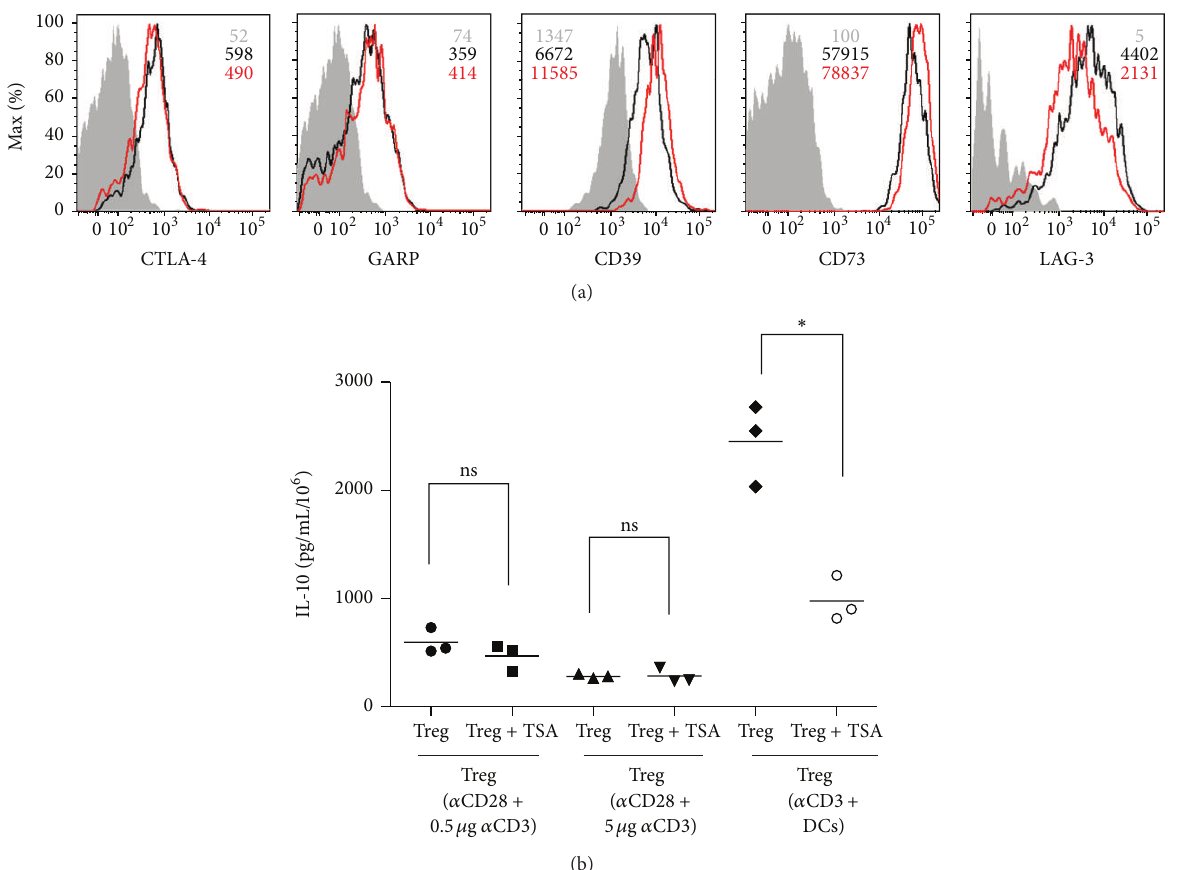
Figure 4: Phenotypical characterization of Tregs generated under TSA treatment. (a) Representative histograms of CTLA-4, GARP, CD39, CD73, and LAG-3 expression on Tregs generated in the absence (black) or presence (red) of TSA. Controls are filled histograms. Average MFI ± SEM was derived from three independent experiments. (b) IL-10 secretion was determined using the CBA method. Each point represents an individual